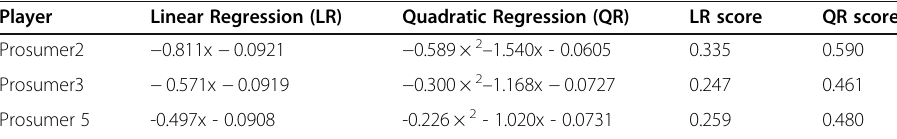
Table 2 Regressions details (information extracted from Web Platform) Player Linear Regression